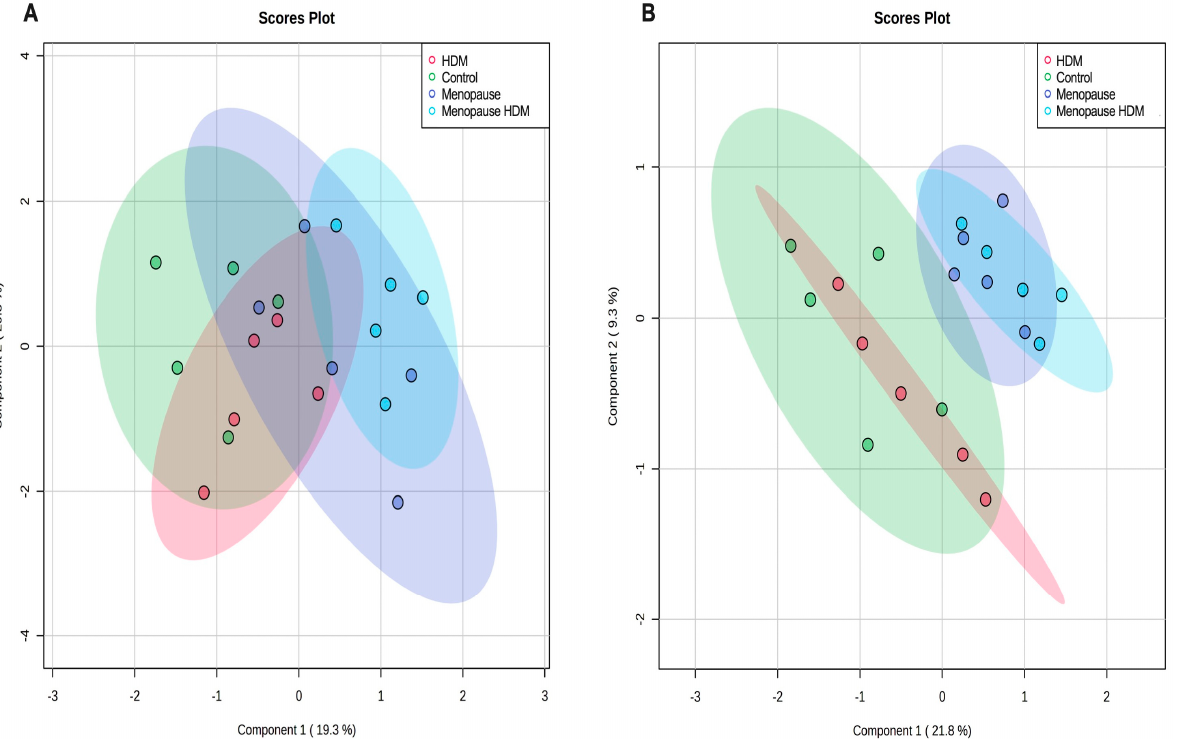
Figure 4. PLS-DA analysis of control, HDM-challenged, menopausal, and menopausal HDM-challenged mice. Score plots of BALF ( A ) and serum ( B ) using all signi fi cant metabolites.